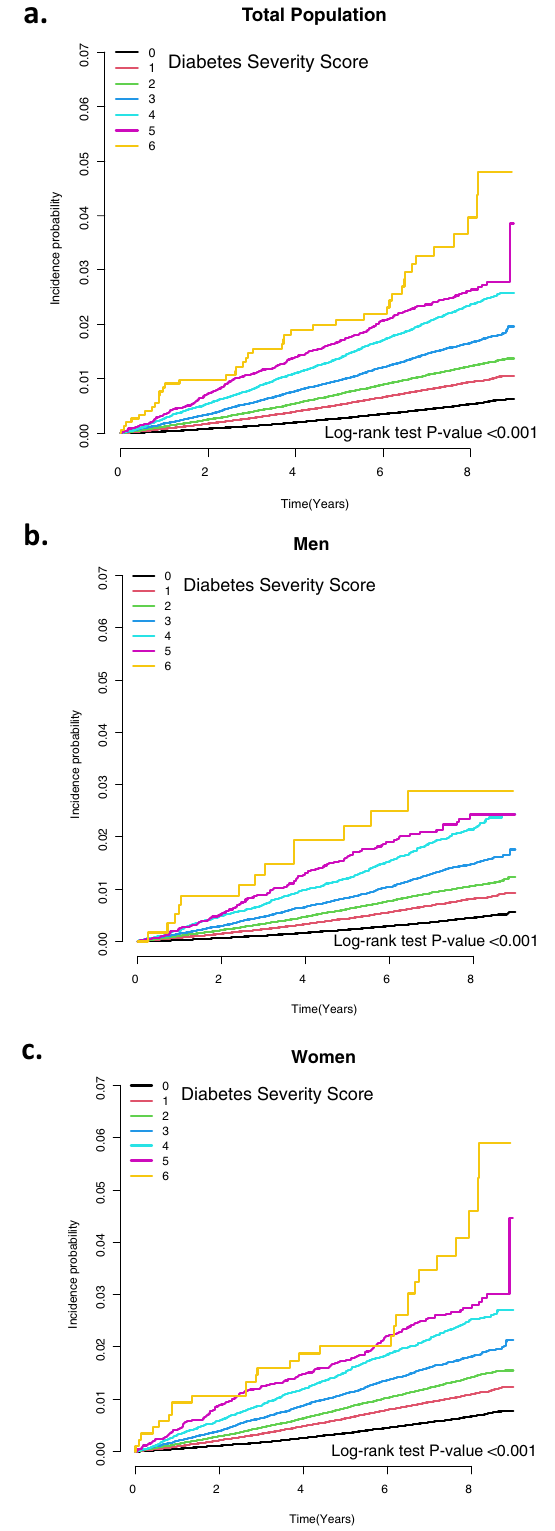
Fig. 1 Kaplan – Meier estimates for the cumulative incidence of Parkinson ’ s disease according to the diabetes severity score (0 – 6). The probability of incident Parkinson ’ s disease according to the diabetes severity score was analyzed for the total population ( a ), men ( b ), and women ( c